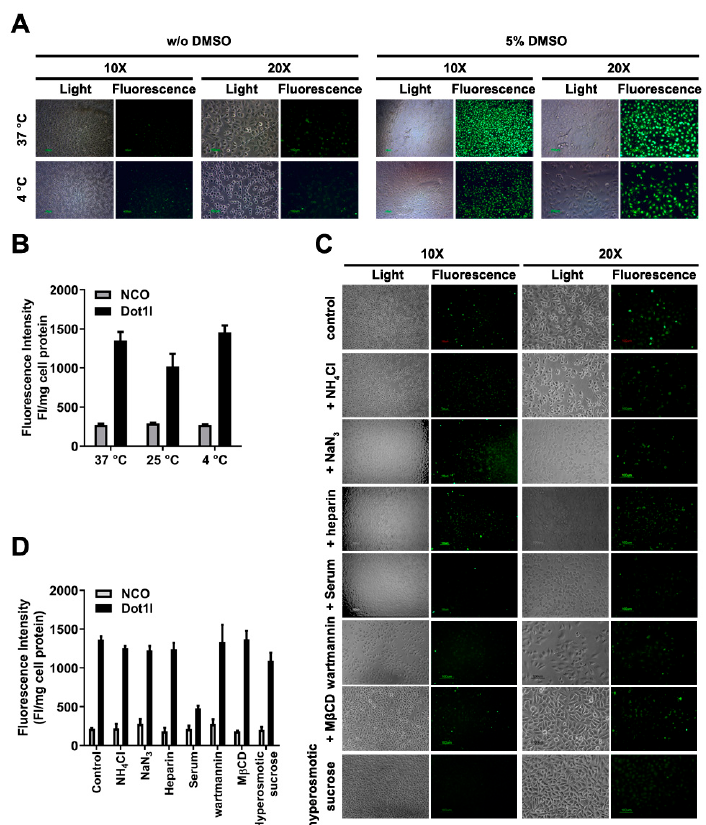
Figure 3. E ff ects of Dot1l peptide penetration under di ff erent conditions. ( A ) Fluorescence microscopy of FITC-labeled Dot1l peptide at 37 ◦ C and 4 ◦ C. ( B ) Quantization of Dot1l peptide penetration in MCF7 cells at di ff erent temperatures. Data are presented as means ± SEM ( n = 3). The statistical analysis is shown in Supplementary Figure S1D. ( C ) Fluorescence microscopy of di ff erent inhibitors’ exposure on Dot1l peptide penetration. ( D ) Suppression of di ff erent inhibitors’ exposure on Dot1l peptide penetration. Data are presented as means ± SEM ( n = 3). The statistical analysis is shown in Supplementary Figure S1E. Cell lysate fluorescence intensity was adjusted by protein concentration examined by Bradford